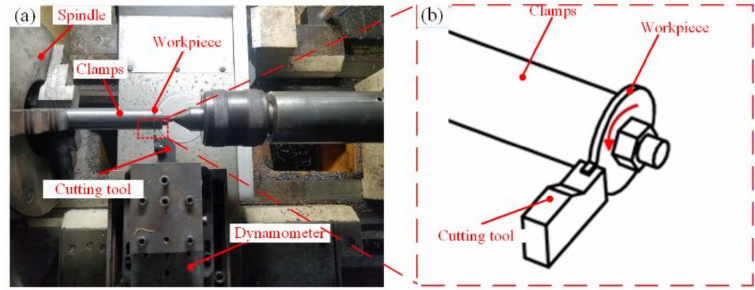
Figure 2. ( a ) Experimental setup, ( b ) schematic diagram of